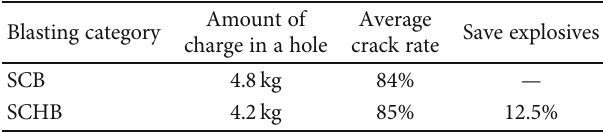
Table 6: Comparison of explosive dosage between SCB and